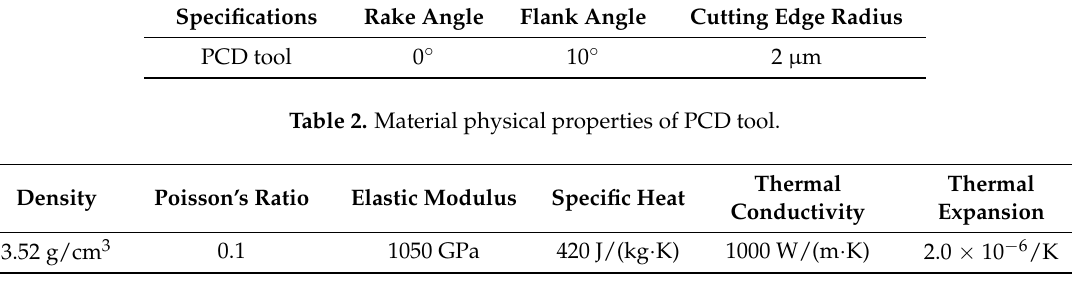
Table 3. Chemical composition of the matrix material.